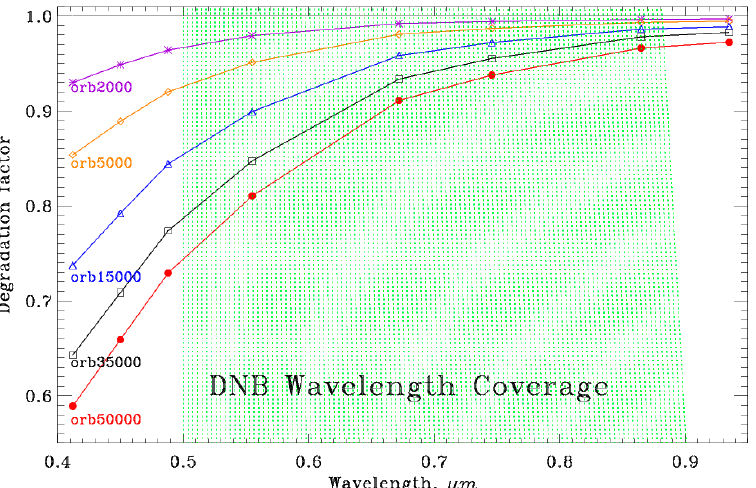
Figure 2. VIIRS SD degradation at five times during the mission as marked by the orbit numbers. Different colors denote different orbits. The DNB wavelength coverage is shaded in green.